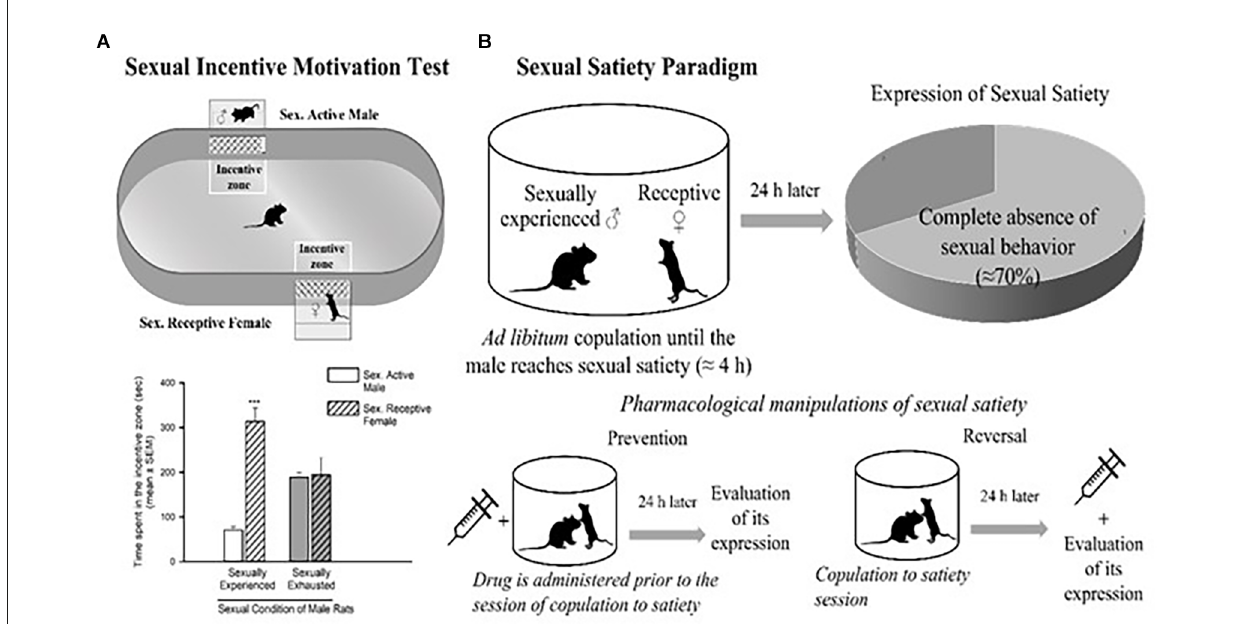
FIGURE2 Sexual incentive motivation test (A) and sexual satiety paradigm (B) . Sexual incentive motivation is measured as the time spent by the male rat in the incentive zones (receptive female or male) of the test field. Sexually experienced males will spend more time in the incentive zone of the sexually receptive female (dashed bars) in comparison with the male (empty bars). Sexually satiated males will spend the same time in both incentive zones. In the sexual satiety paradigm, sexually experienced males in the course of an ad libitum copulation session will ejaculate repeatedly (7 in ≈ 4 h) until reaching sexual satiety. Twenty-four hours after copulation to satiety, most males ( ≈ 70%) will not respond with sexual behavior when a receptive female is accessible. Pharmacological treatments can modify the features of the sexual satiety paradigm, the most important being the increase in the percentage of sexually satiated male rats exhibiting sexual behavior expression with a receptive female. If a drug treatment is administered prior to the copulation to satiety session, the result (percentage of animals exhibiting sexual behavior) will reflect the prevention of the establishment of sexual inhibition. If the treatment is administered 24 h after the sexual satiety session, the result will reflect a reversal. Figures modified from Canseco-Alba and Rodríguez-Manzo